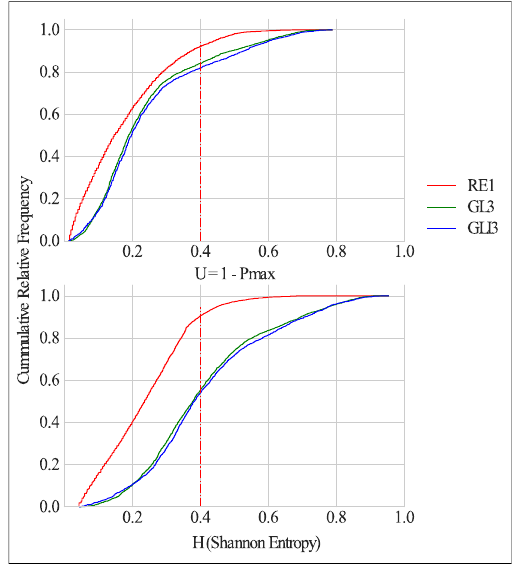
Figure 5. The Shannon entropy (H) clearly reveals uncertainty difference in thematic maps from RE1 and GL3 RR models: As example, the proportion of pixels with uncertainty below 0.4.